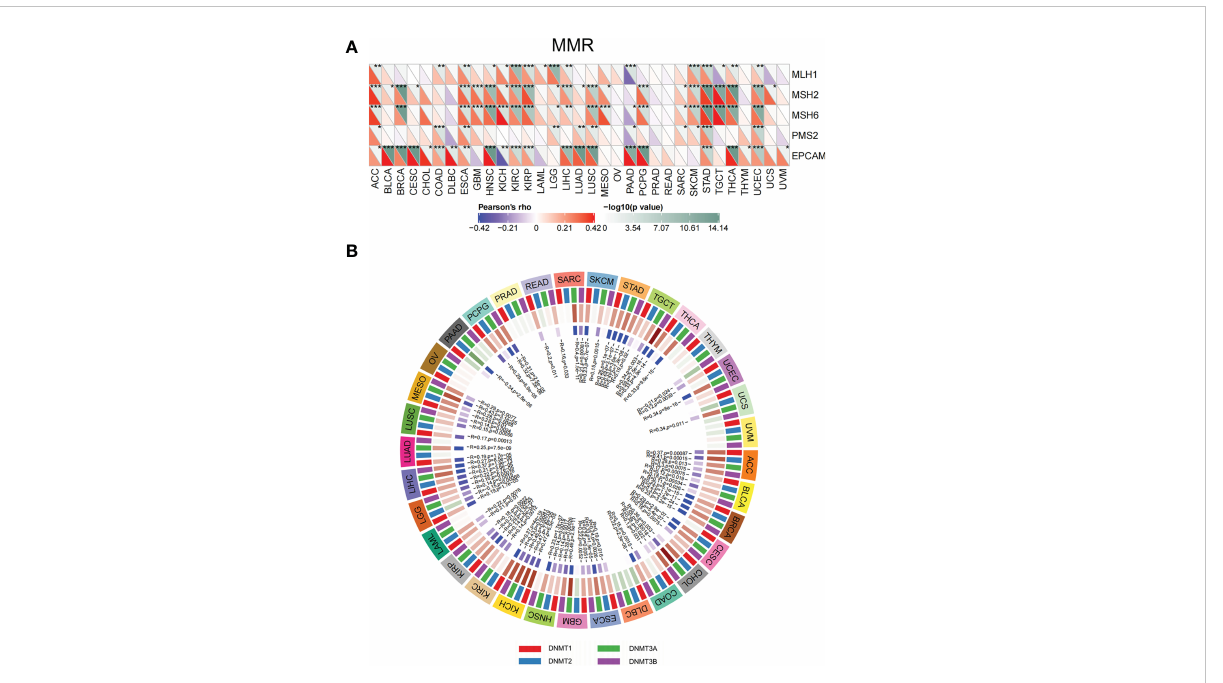
FIGURE 8 Correlations between ETV4 expression, mismatch repair genes, and DNA methyltransferases among different cancers. (A) Relationship between ETV4 expression and mismatch repair genes. The upper triangle of each square represented the magnitude of the p value of the correlation test, and the lower triangle represented the magnitude of correlation coef fi cient. (B) Correlation between ETV4 expression and DNA methyltransferases (Red/ green in the third layer referring to correlation coef fi cient and blue/purple in the forth layer referring to p-value).*p < 0.05, **p < 0.01, ***p < 0.001.